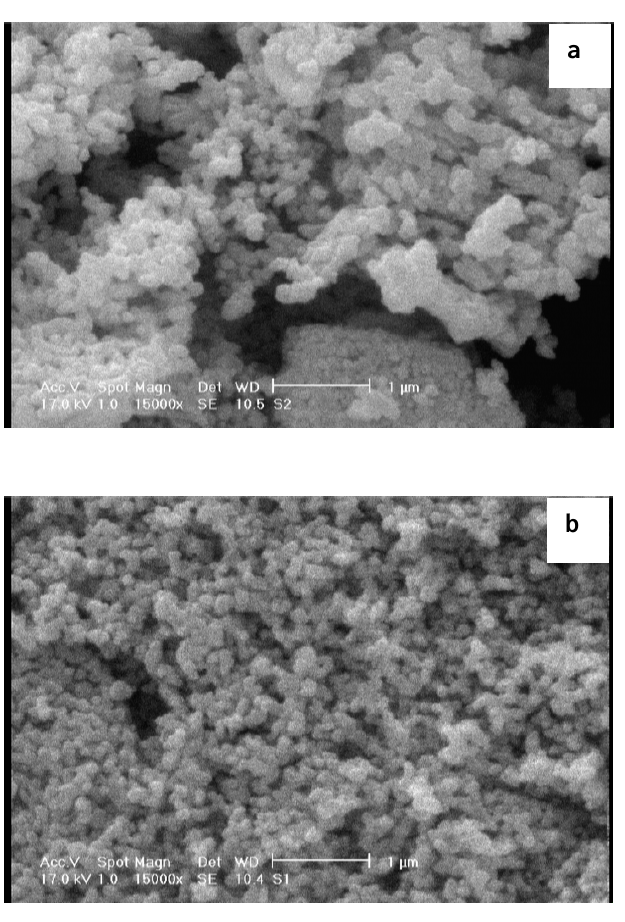
Fig. 5. SEM images of ZnO nanoparticles fabricated from calcinations process of a) 1 at 530 °C and b) 2 at 550